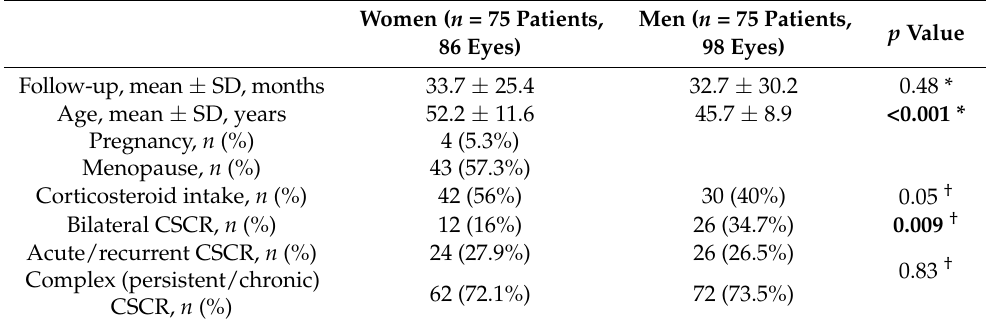
Table 1. Comparison of patients’ demographics and the clinical forms of central serous chorioretinopa- thy, according to gender.